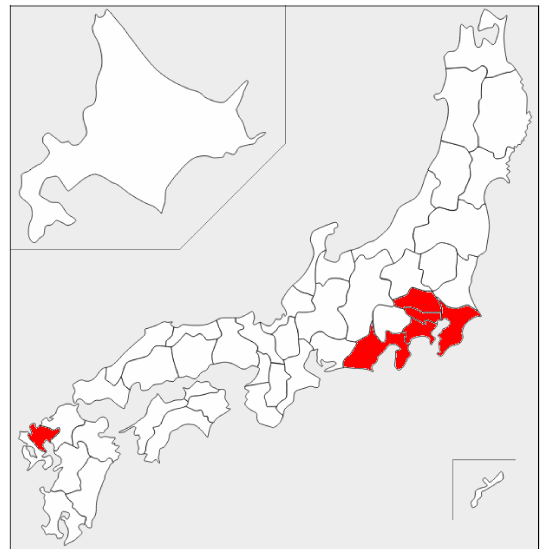
Figure 1. Target area of the experiments (in red). Extremely warm or cold regions were